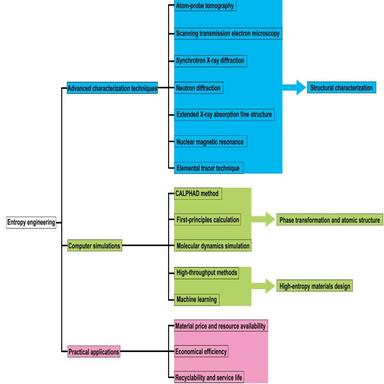
Possible research directions of entropy engineering.